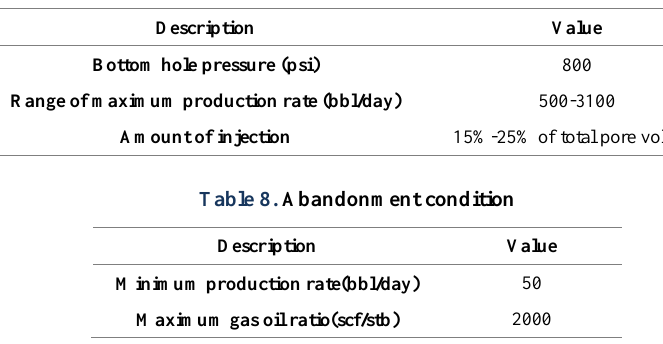
Table 7. Operational condition